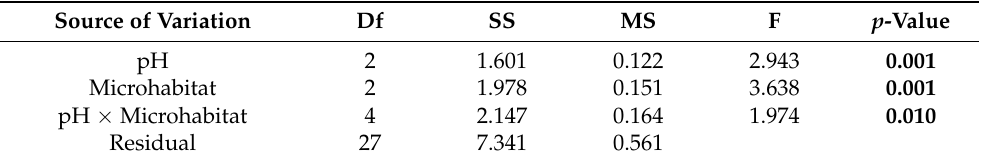
Table 6. Results of PERMANOVA on mollusc assemblages found on P. oceanica meadow at the Vu site. Significant values are highlighted in